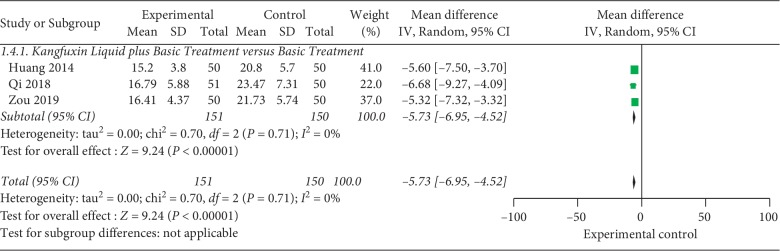
Cure time of KFXL combined with basic treatment versus basic treatment.